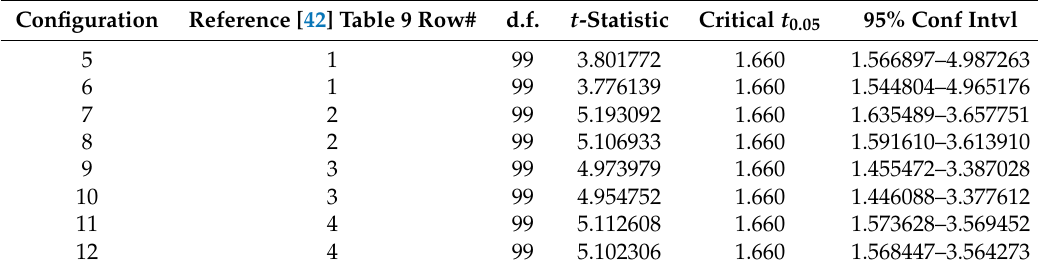
Table 20. The method in [42] versus the proposed method: results of Smith–Satterthwaite tests for comparing the means of 100 best-of-run costs for each configuration.